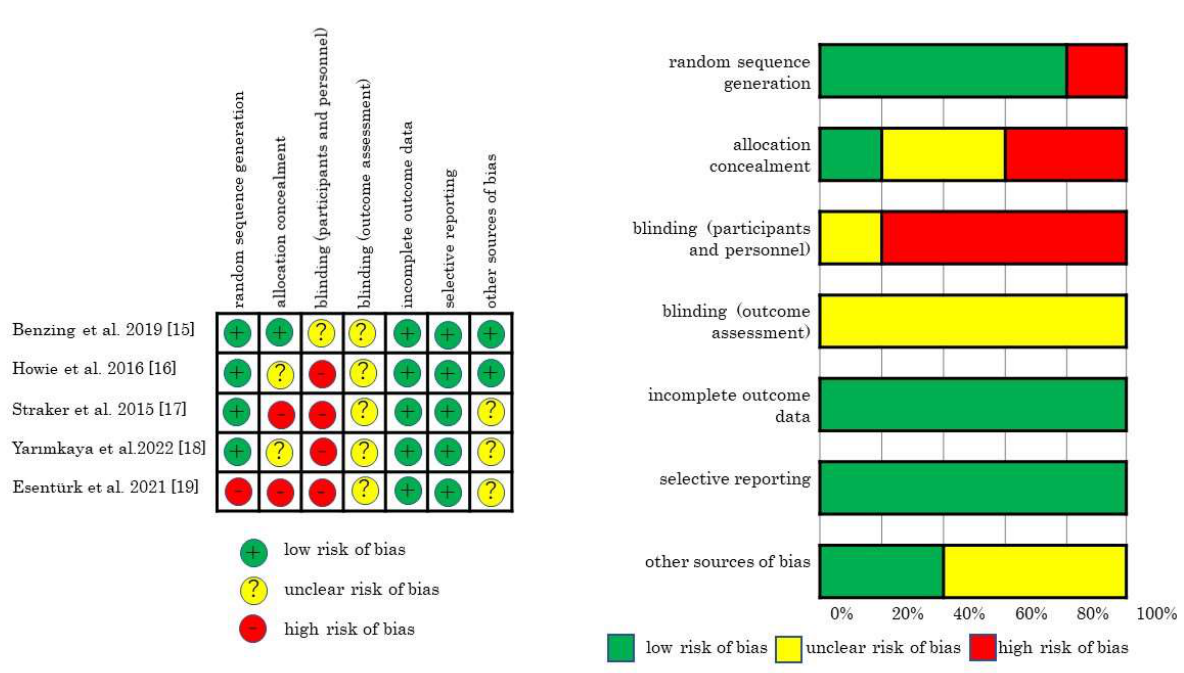
Figure 2. The risk of bias of each study and domain.